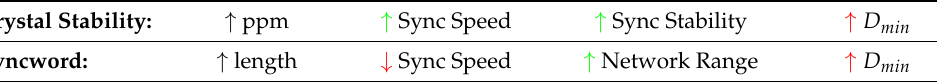
Table 2. Design trade-off space. Low crystal stability implies wide frequency variation of individual nodes, which enhances synchronization speed and stability (leader node is faster than second-fastest node) at the cost of increased duty-cycle. High syncword duration implies higher SNR and longer synchronization range at the cost of higher power. Arrows ( ↑↓ ) show relationships; colors indicate ↑ neutral, ↑ wanted, ↑↓